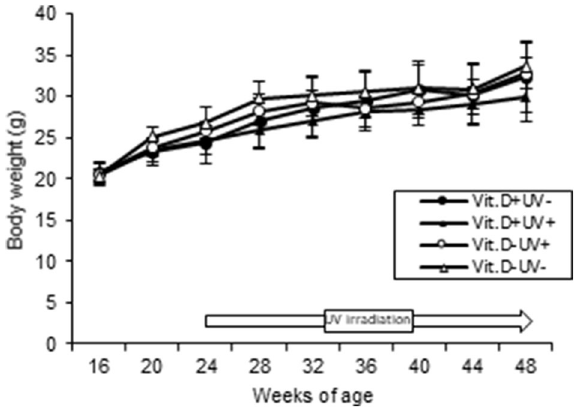
Figure 4. Body weight growth curves of ovariectomized female mice. Ovariectomized mice were divided into 4 groups, and fed either vitamin D–containing diet (Vit.D +) (2 groups) or diet without vitamin D (Vit.D−) (2 groups) from OVX weeks of age. UV was either irradiated or not from 24 to 48 weeks of age, the end of the study. The mice were finally divided into 4 groups. UV ultraviolet irradiation.